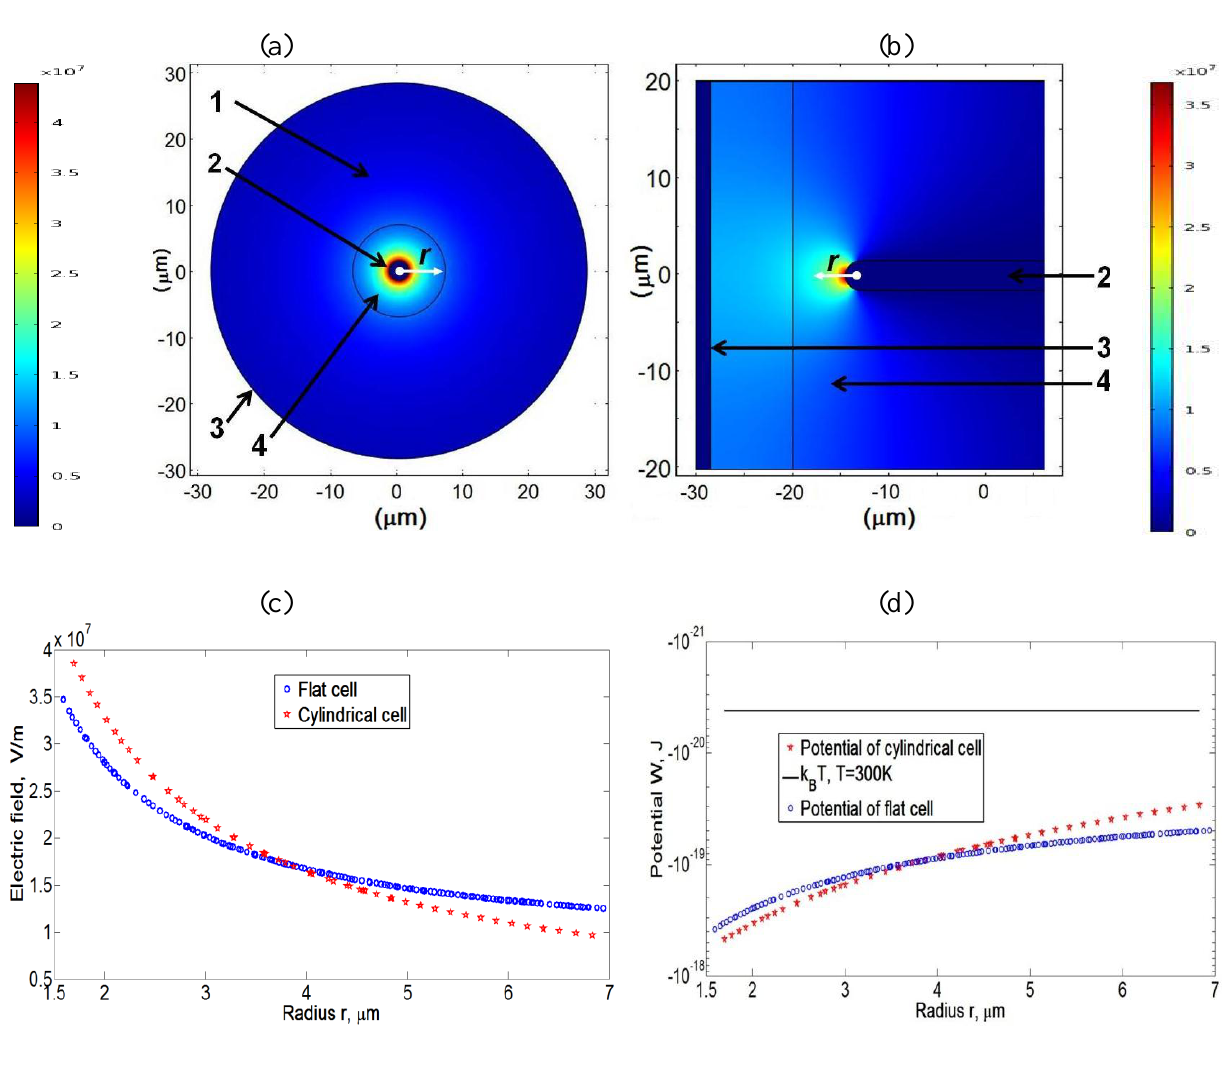
Figure 3. Spatial map of the electric field in the cylindrical cell filled with pure toluene, under an applied voltage 200V; 1 is the glass capillary, 2 is the central electrodes running along the axis of the cylindrical cavity, 3 is the outer electrode, and 4 is toluene, filling the gap between the central electrode and the inner surface of the glass shell ( a ). The same for the flat cell; 2 is the “central” electrode connected to a waveform generator, 3 is the grounded electrode perpendicular to the electrode 2, and 4 is toluene ( b ). The electric field ( c ) and the dielectrophoretic potential ( d ) for two cells, as the function of a radial distance 𝑟 measured from the axis of the cylindrical cell in ( a ) and from the center of the semispherical tip of central electrode in ( b